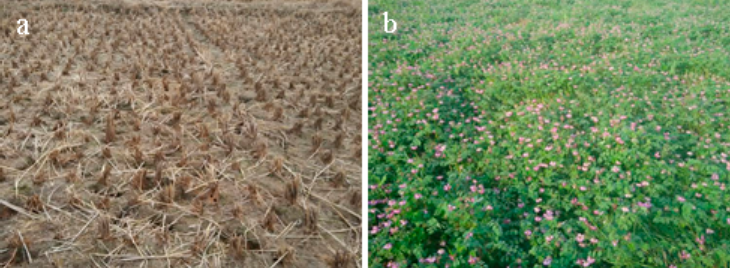
Figure 1. Planting patterns of the winter fallow ( a ) and the winter cover cropping with milk vetch ( b ) in a double-rice cropping system.